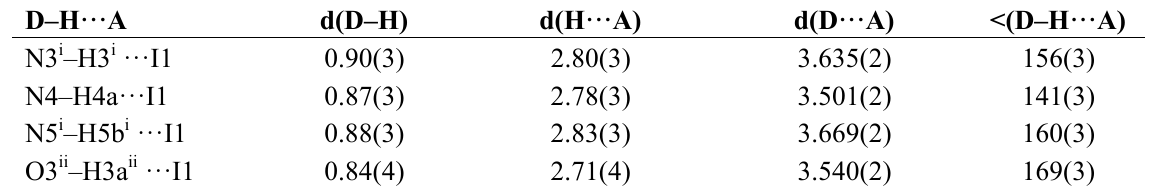
Table 7. Selected hydrogen bonds in the structure of 4